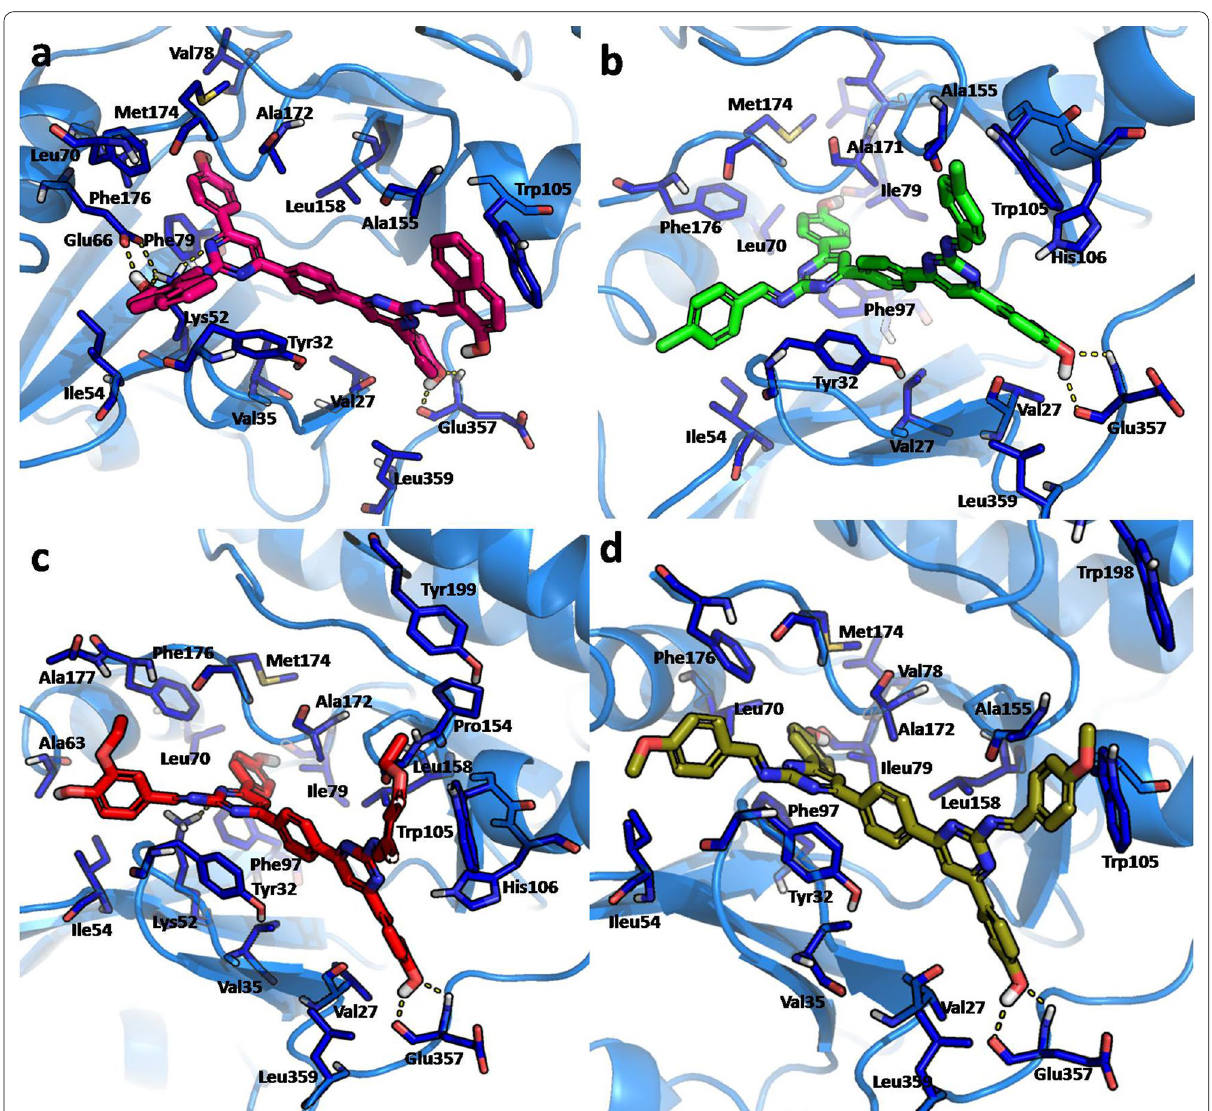
Fig. 5 a Graphical illustration of predicted binding mode of bis-pyrimidines in the active site of CDK8. a Compound q1 (magenta color), b Com- pound q5 (green color), c Compound q8 (red color), d Compound q13 (split pea color). Key residues (lines) are only shown and Compounds are represented as sticks. The hydrogen bond interactions are represented by yellow dashed